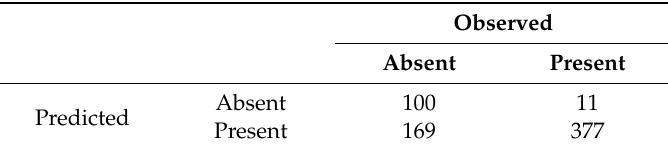
Figure 1. Eurasian watermilfoil (EWM) occurrence predictions for N = 657 surveyed lakes. Maps depict true presences ( a ), true absences ( b ), false absences ( c ), and false presences ( d ). Binomial response generalized linear models (GLMs) fit with Firth’s bias reduction method [24]. Table 2. Cross-validated confusion matrix relating observed to predicted EWM occurrence in the 657 surveyed lakes. We set the threshold for classifying the predicted probability as presence at 0.246, a value that minimizes false absences to less than 10% of all predicted absences.